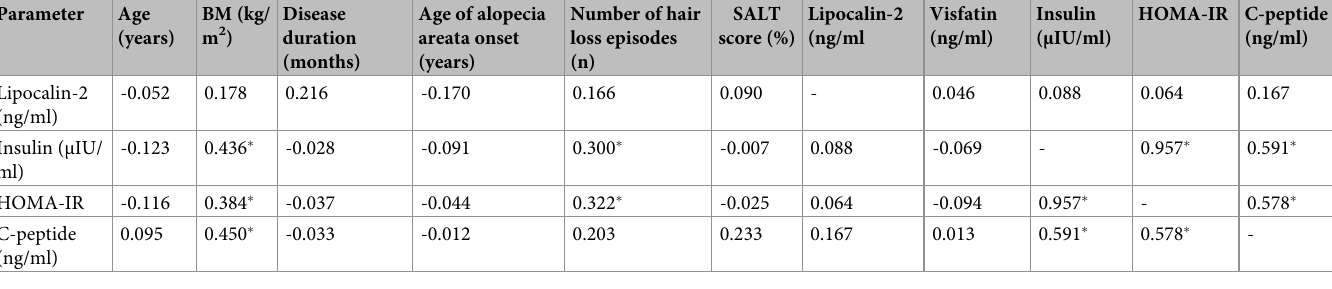
Table 5. Spearman’s correlation coefficients between selected clinical and laboratory parameters in patients with alopecia areata.